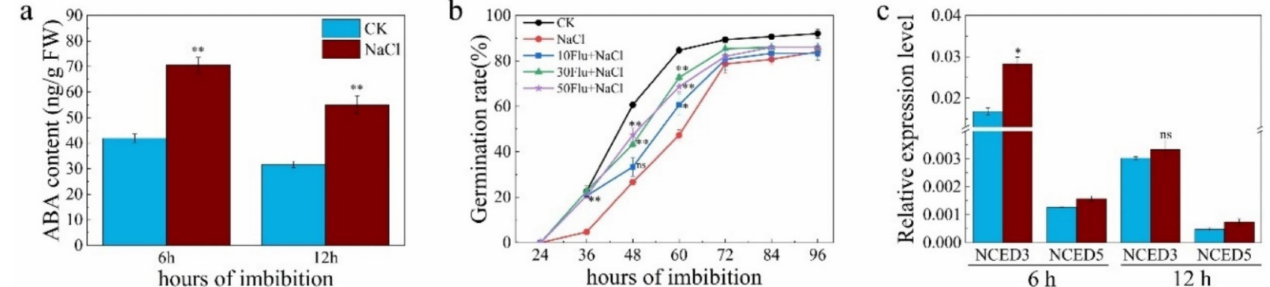
Figure 3. Salt stress increased ABA biosynthesis in both WT and triple mutants during seed germina- tion. ( a ) ABA content of WT seed germinated under water and 100 mM NaCl; ( b ) Seed germination under water and 100 mM NaCl plus different concentrations of fluridone (0, 10, 30 and 50 µ M); ( c ) Expressions of OsNCED3 and OsNCED5 in WT germinated under water and 100 mM NaCl solution. The data are the means of three independent replications ( n = 20) ± SD. The asterisk (* and **) indicates a significant difference at the p < 0.05 and p < 0.01 level, and ns means not significant, respectively, by Student’s t -test